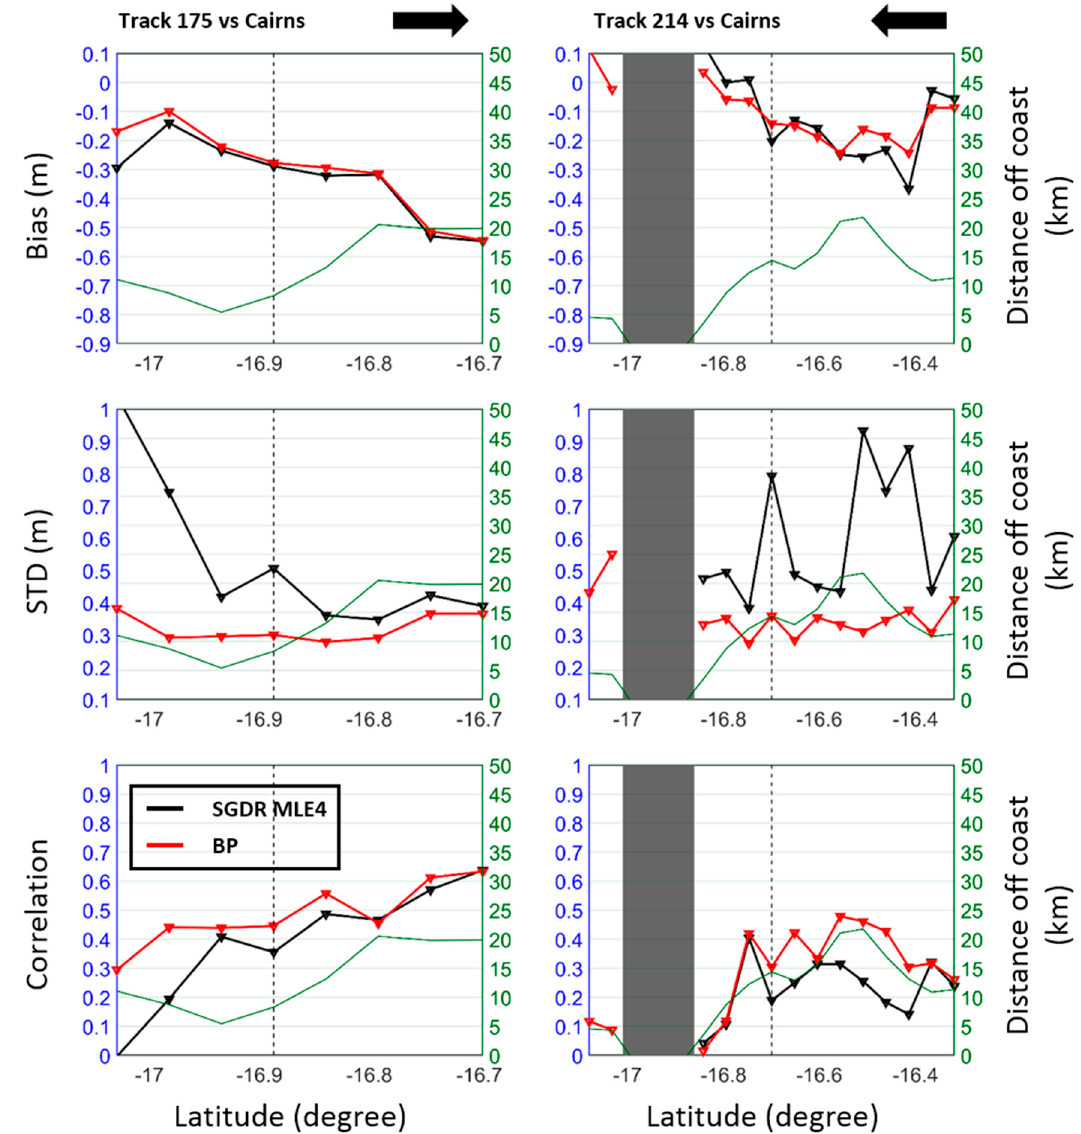
Figure 5. Validation of 1 Hz along-track SWHs for tracks 175 ( left ) and 214 ( right ) against buoy SWHs at Cairns in North Queensland in terms of point-wise bias, STD and correlation coefficients. The 1 Hz SWHs are derived from the SGDR MLE4 (black) and BP (red) retracker. The black arrow on the top indicates the flight direction of the satellite. The grey area indicates the land, and the green line represents the distance of the along-track points off the coast. The black vertical dash line denotes the closest point of the track from the buoy.